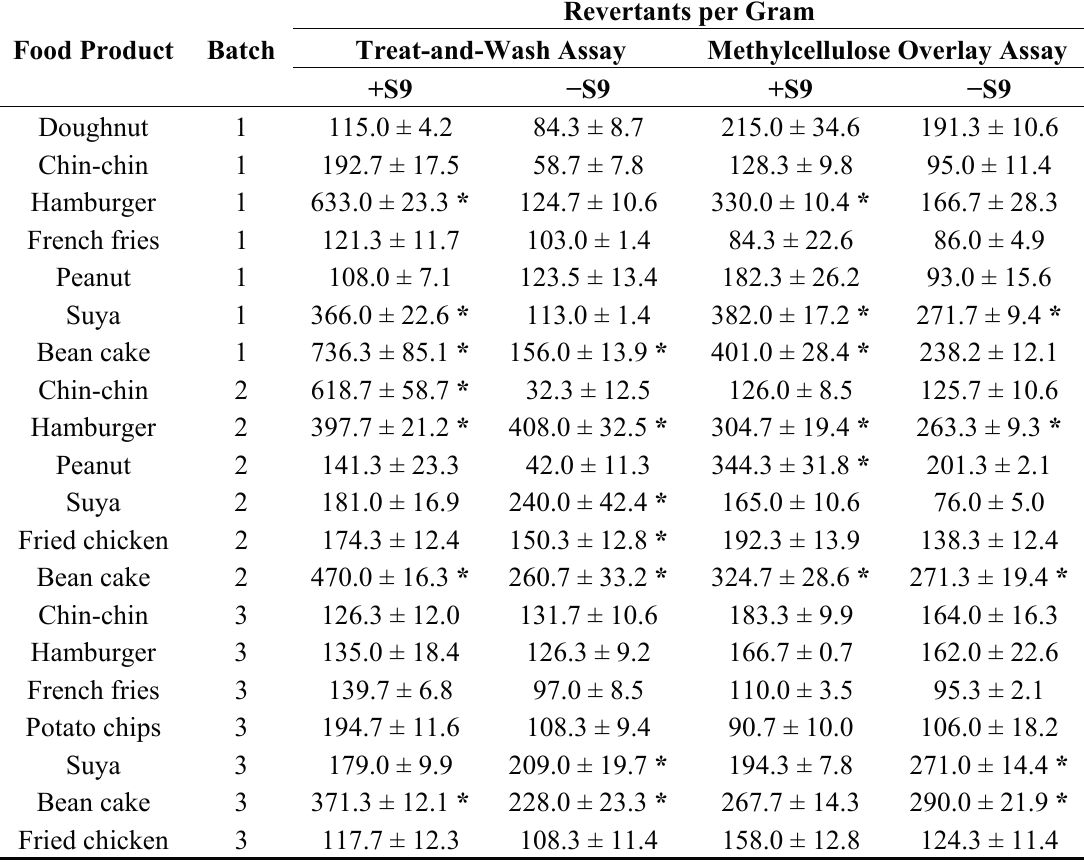
Table 4. Number of revertants in the treat-and-wash as well as methylcellulose overlay assays generated by the highest concentrations (1.0 per g of food sample) of food extracts showing mutagenic potential on Salmonella TA 100 (mean ± SD) in the standard plate incorporation assay.